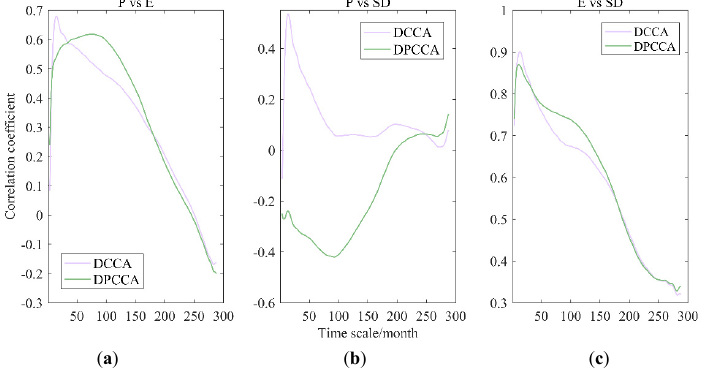
Figure 5. Cross-correlation coefficients among P, E, and sunshine duration (SD) obtained by DCCA cross-correlation coefficient and DPCCA, i.e., P-E ( a ), P-SD ( b ), and E-SD (c).